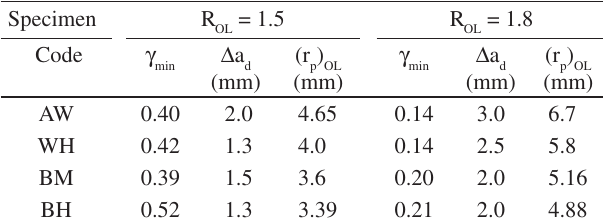
and ∆ a determined min d